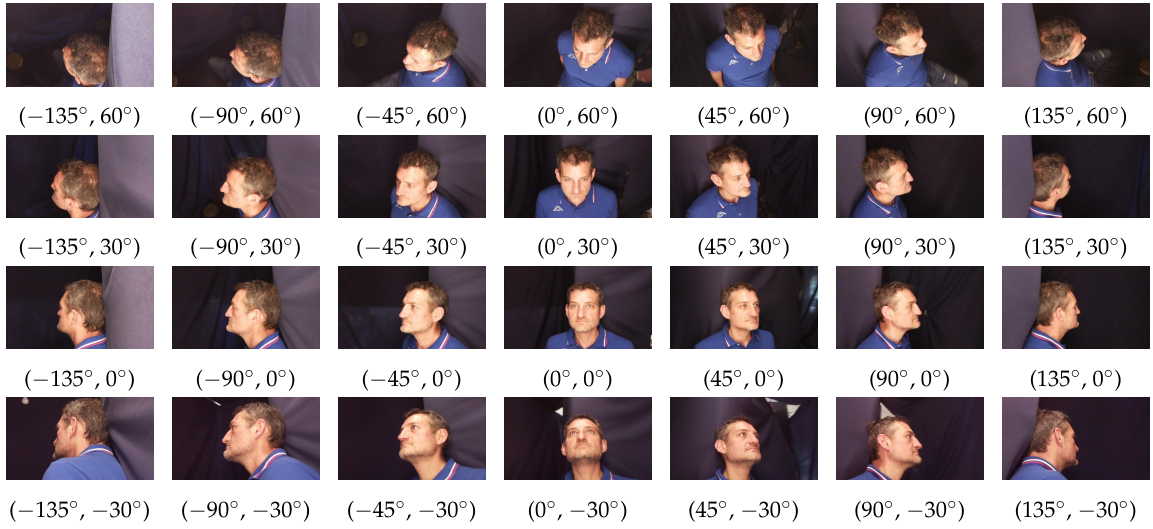
Figure 1. A sample of the mugshots available for each subject in the FRMDB. For each mugshot, the angles from which the picture was taken are reported as a couple ( h , v ) : h is the angle on the horizontal plane from − 135 ◦ to +135 ◦ , with an increment of 45 ◦ between an angle and its adjacent (from left to right); v is the angle on the vertical plane from 60 ◦ to − 30 ◦ , with a step of − 30 ◦ between an angle and its adjacent (from top to